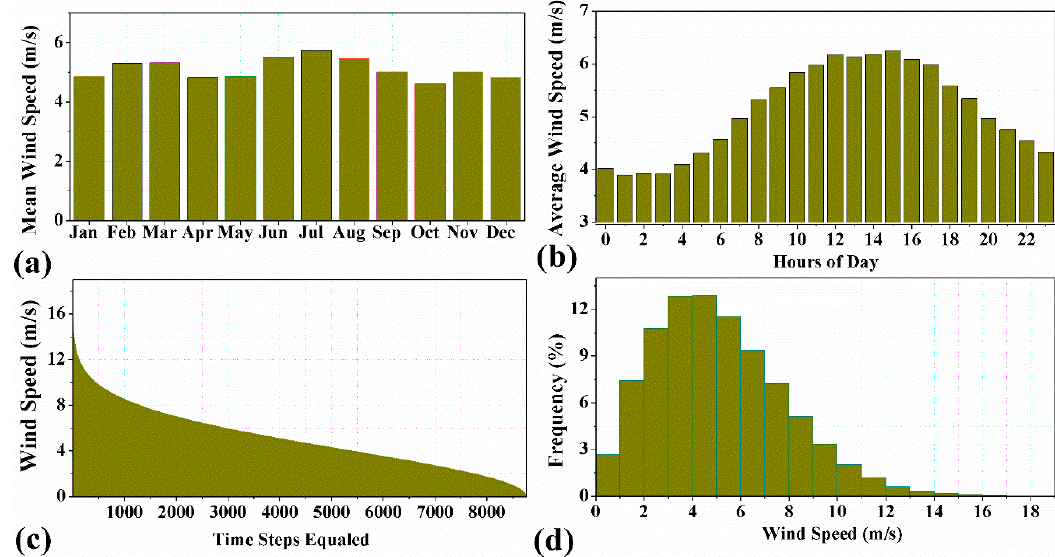
Figure 4. Wind Resources in Majmaah. ( a ) Monthly average wind speed; ( b ) Hourly average wind speed; ( c ) Wind speed duration curve; ( d ) Wind speed histogram.